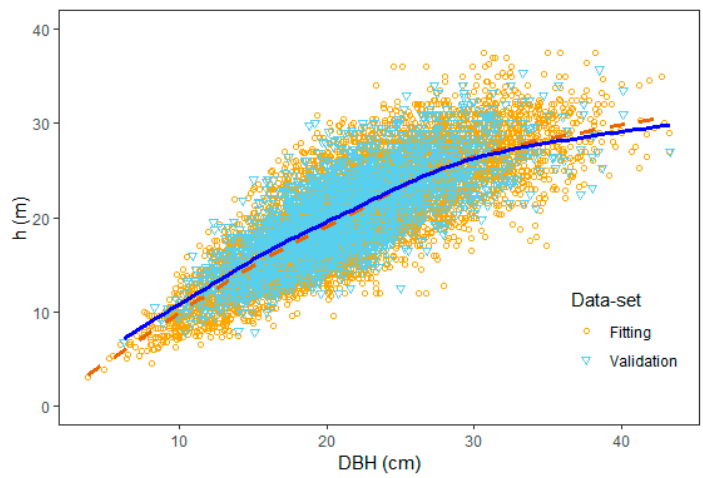
Figure 1. Dispersion of paired diameter at breast height (DBH) and h data in fit and validation data-sets used to represent the height–diameter relationship (Approach 1).